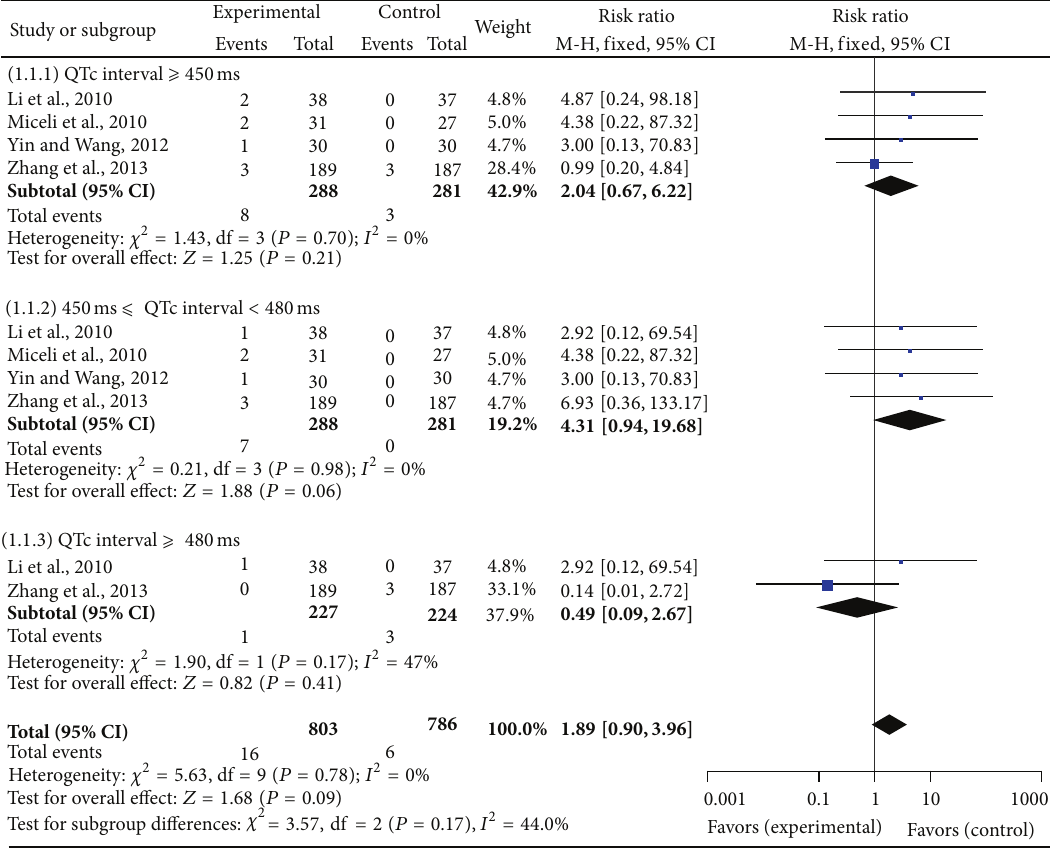
ziprasidone was already prolonged with a QT/QTc of 484/475 milliseconds at a pulse of 58 beats per